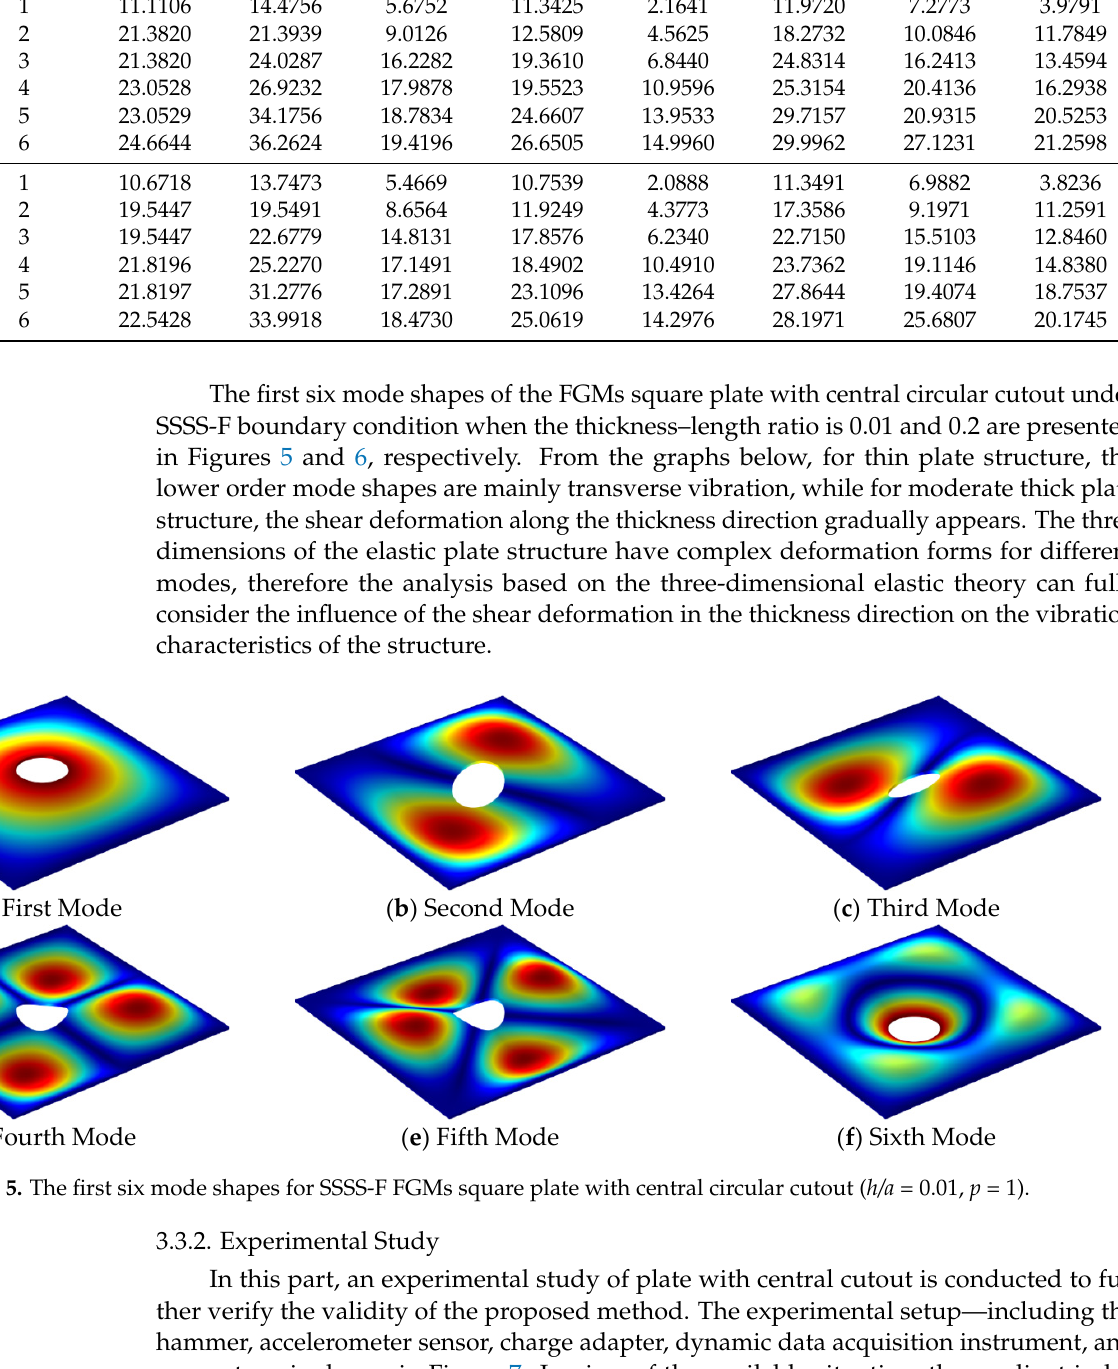
( f ) Sixth Mode Figure 6. The first six mode shapes for SSSS-F FGMs square plate with central circular cutout ( h/a = 0.2, p = 1 ) . 3.3.2. Experimental Study In this part, an experimental study of plate with central cutout is conducted to further verify the validity of the proposed method. The experimental setup—including the ham- mer, accelerometer sensor, charge adapter, dynamic data acquisition instrument, and computer—is shown in Figure 7. In view of the available situation, the gradient index is considered to be infinity, thus the functionally graded material degenerates to be com- pletely aluminum. A square plate with central circular cutout under FFFF-F and CCCC-F boundary condition are examined. It is impossible to realize the complete free boundary condition in the actual experimental environment, two small holes are opened on the edge of the structure, and elastic rubber ropes are used to hang the structure on the frame, as shown in Figure 8a. For the CCCC-F boundary condition, the experimental model adopts two thicker L-shaped plates and arranges bolts uniformly around the rectangular plate structure to simulate the fixed boundary condition, as shown in Figure 8b. The parameters of dimension and the material of the structure are given in Table 6. Table 7 shows the first six natural frequencies of the structure obtained by the present method and the experi- ment. Through the comparative analysis of experiments and the calculation of the pro- posed method, the difference is 4.754% for the worst case, which is acceptable. The main